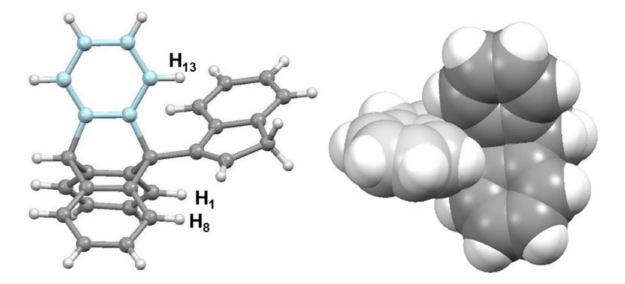
Figure 6. Molecular structure of 9-(3-indenyl)triptycene, 8 , and a space-fill view, from the reverse angle, to emphasise its molecular crowding.